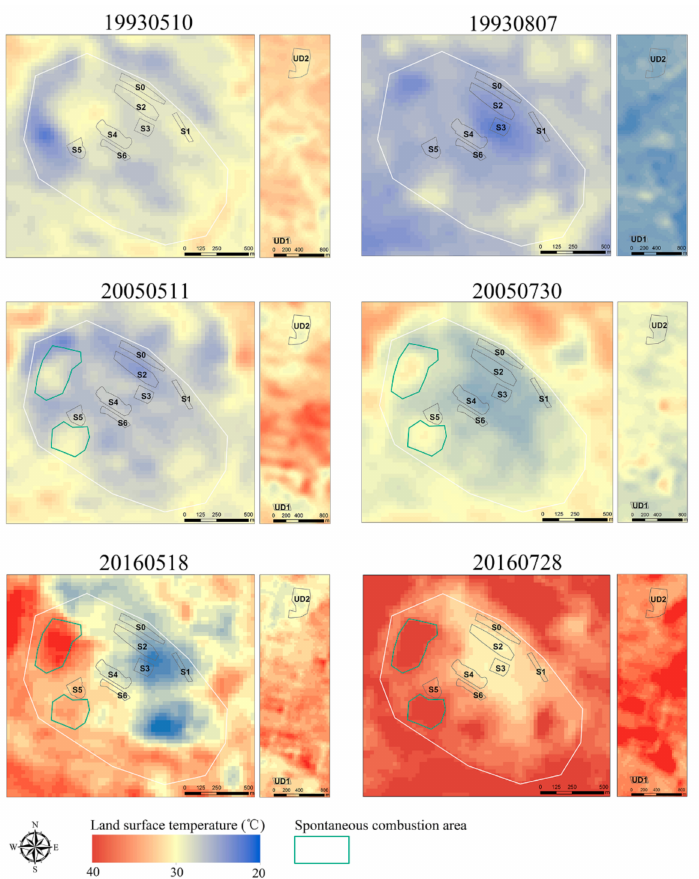
Figure A2. Land-surface temperature (LST, ◦ C) in May and August 1993, 2005, and 2016. LST in 1993 and 2005 calculated using the land-surface-temperature retrieval method by Sobrino et al. [102]. LST in 2016 calculated with Bands 10 and 11 in Landsat 8 using split-window algorithm